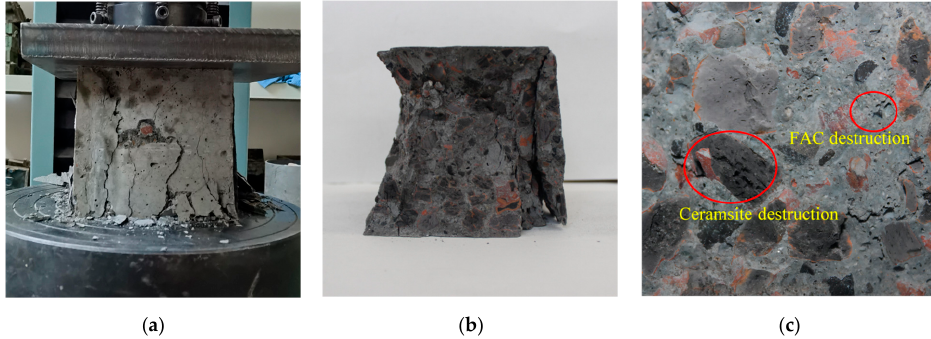
Figure 5. The damage patterns of the FDCC: ( a ) surface cracks; ( b ) overall damage; ( c ) aggregate damage.